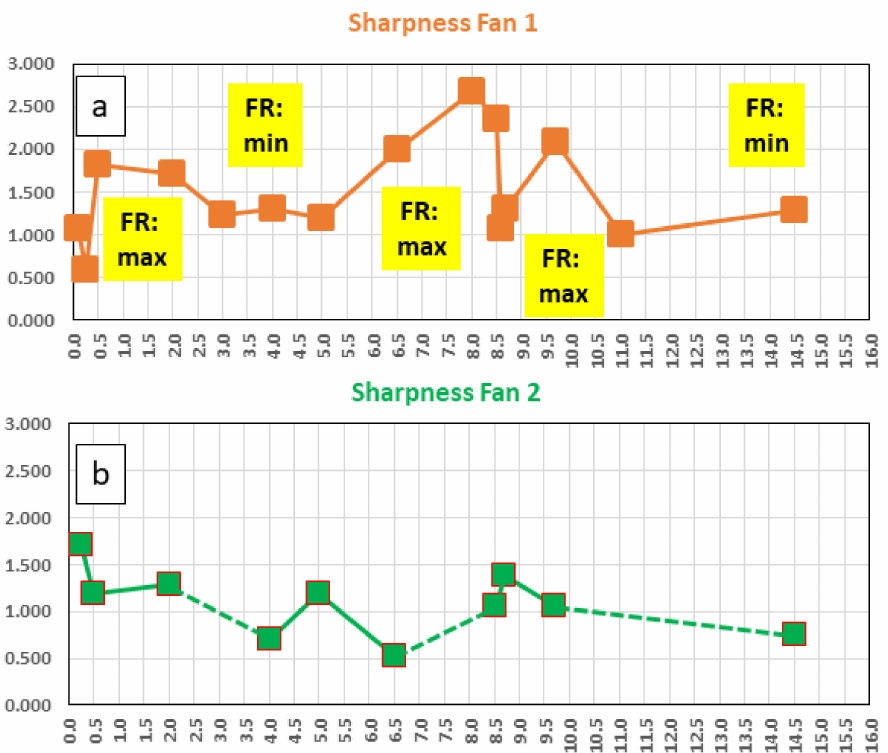
Figure 19. Situmetry (intensity of maxima and fans = sharpness ratio) vs. topography, x-axis denotes in graphs the distance to the source area in km and the sampling sites shown in Figures 3 and 5. ( a ) The sharpness ratio of the first order maximum (brown). ( b ) The sharpness ratio of the second order maximum (green). For calculation see text. The yellow boxes give the flow rate maxima and